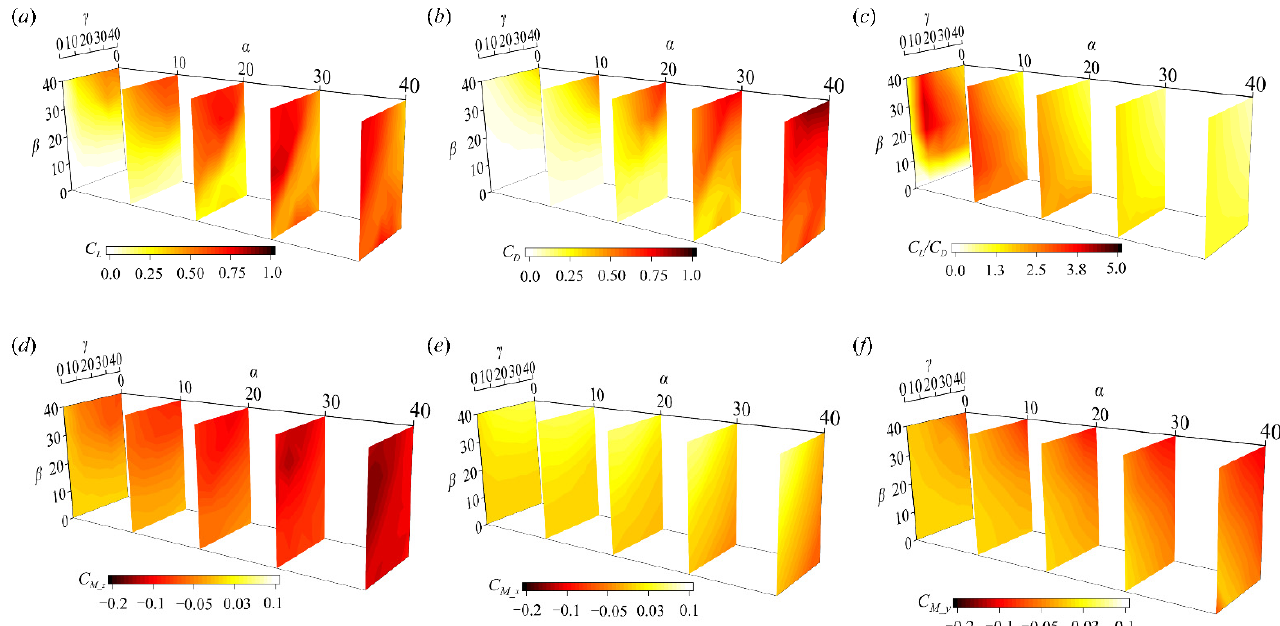
Figure 5. Aerodynamic forces and moments of the ski at different attitude angles: ( a ) lift, ( b ) drag, ( c ) lift-to-drag ratio, ( d ) pitch moment, ( e ) yaw moment, and ( f ) roll moment. The aerodynamic moments corresponding to the airflow ( C M_z , C M_x , and C M_y ) are shown in Figure 5d–f. Within the range of α , β , and γ , C M_z experiences a more significant